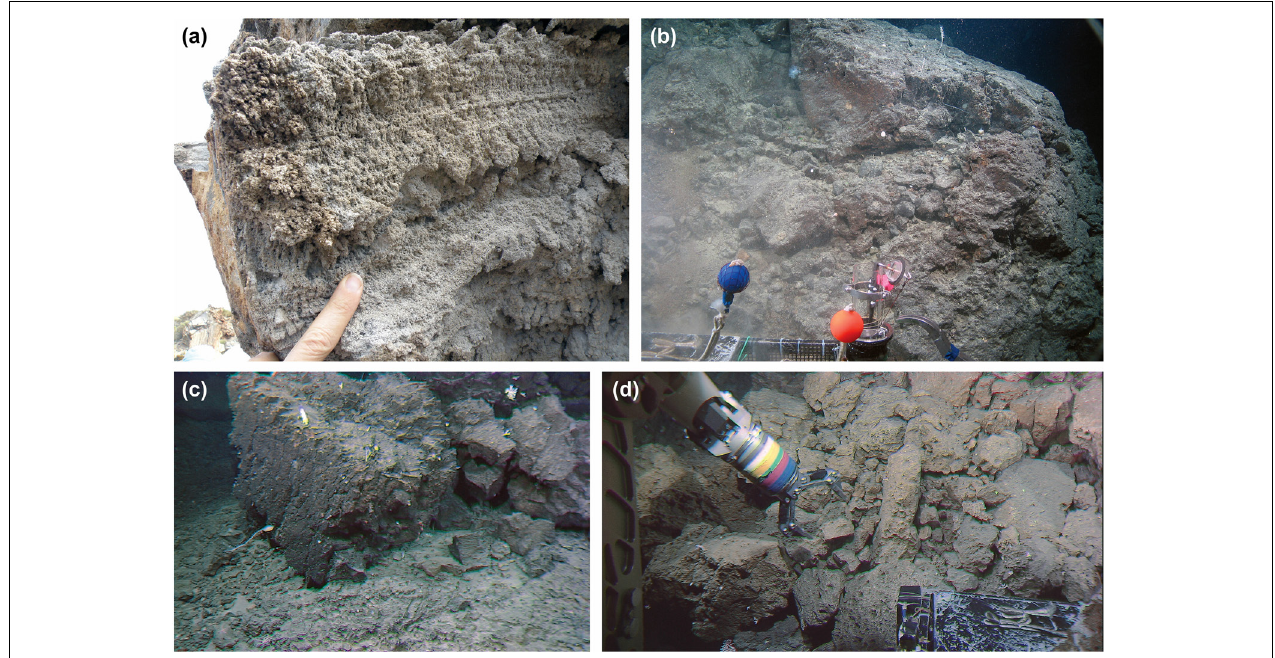
FIGURE 5 | Coherent and autoclastic pumice carapaces on felsic lavas. (a) Subaerial rhyolitic Rocche Rosse lava, Lipari Island, Italy, showing an in situ , flow-banded, highly vesicular, coherent pumice domain. (b) Highly vesicular, coherent rhyolitic pumice surface of submarine lava dome at water depth of 1210 m, from Sumisu submarine volcano, Izu-Bonin arc, Japan, showing a rough columnar jointing on curvi-planar surface on right side. Field of view: 5 m wide. (c) polygonal giant pumice blocks, Sumisu volcano, 960 m water depth. The large block is 3 m in diameter and the left hand planar surface shows small scale polygonal, cooling jointing. (d) 5–30 cm diameter pumice blocks, some with planar surfaces and polygonal form, Sumisu volcano, water depth of 430 m. [ (b–d) are from Allen et al. (2010), parts a, c, e, of Figure 2 , reproduced with permission of the senior author S. Allen, and under “fair use” provisions of the Geological Society of America: https://www.geosociety.org/GSA/Publications/InfoServices/Copyright/GSA/Pubs/guide/copyright.aspx].